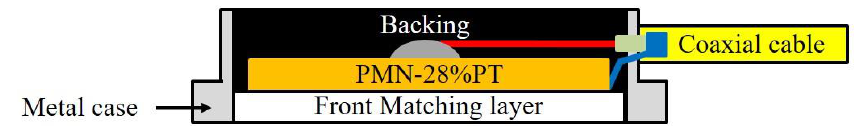
Figure 5. Structure of the PMN-28%PT ultrasonic transducer developed for non-destructive evaluation (NDE) of PWR fuel rods.